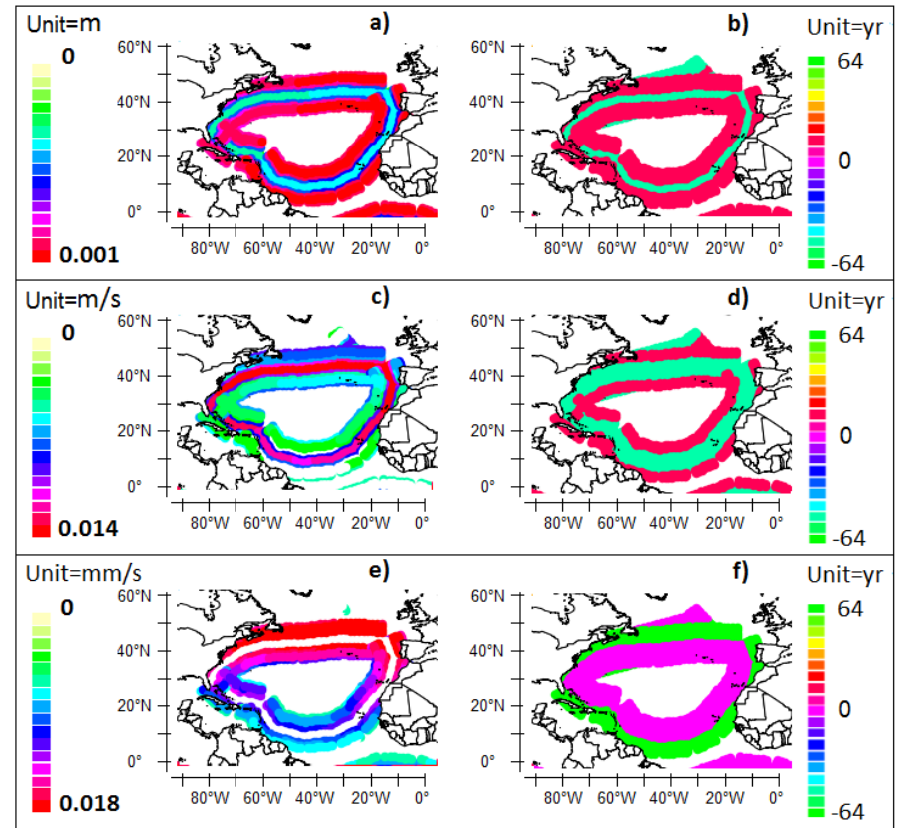
Figure 6. Cross-wavelet representation of the solution of the equations of motion for the 128-year period. ( a ) Amplitude and ( b ) phase of the antinode around the gyre ( η is the SSH anomaly resulting from the oscillation of the pycnocline depth in m); ( c ) Speed and ( d ) phase of the modulated polar current velocity; ( e ) Speed and ( f ) phase of the modulated radial current velocity. The phase refers to the modulated radial current velocity when it flows from the left to the right of an observer who travels along the gyre anti-cyclonically.